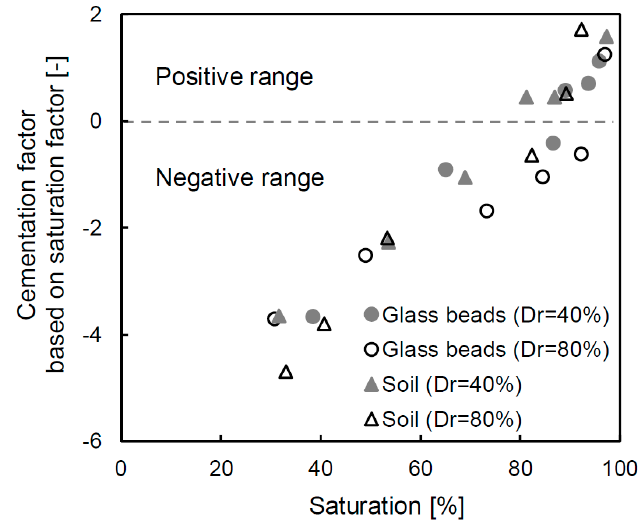
Figure 10. Distribution of the cementation factors based on every saturation factor.